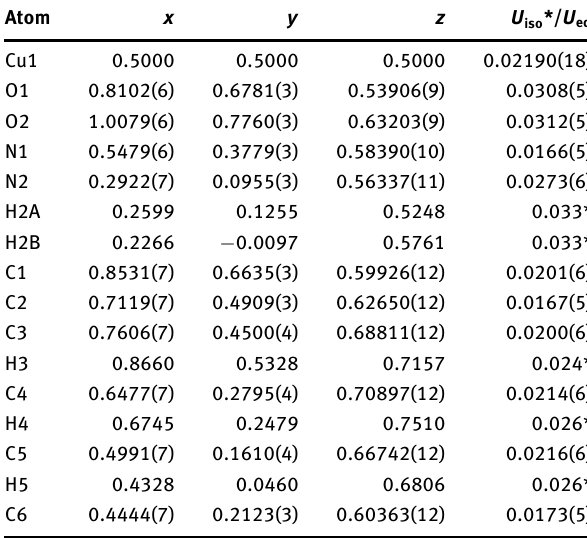
Hydrogen atoms were placed in their geometrically idealized positions and constrained to ride on their parent